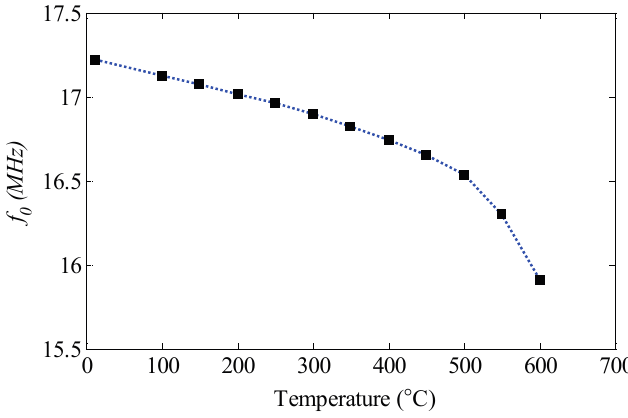
Figure 8. Resonant frequency versus